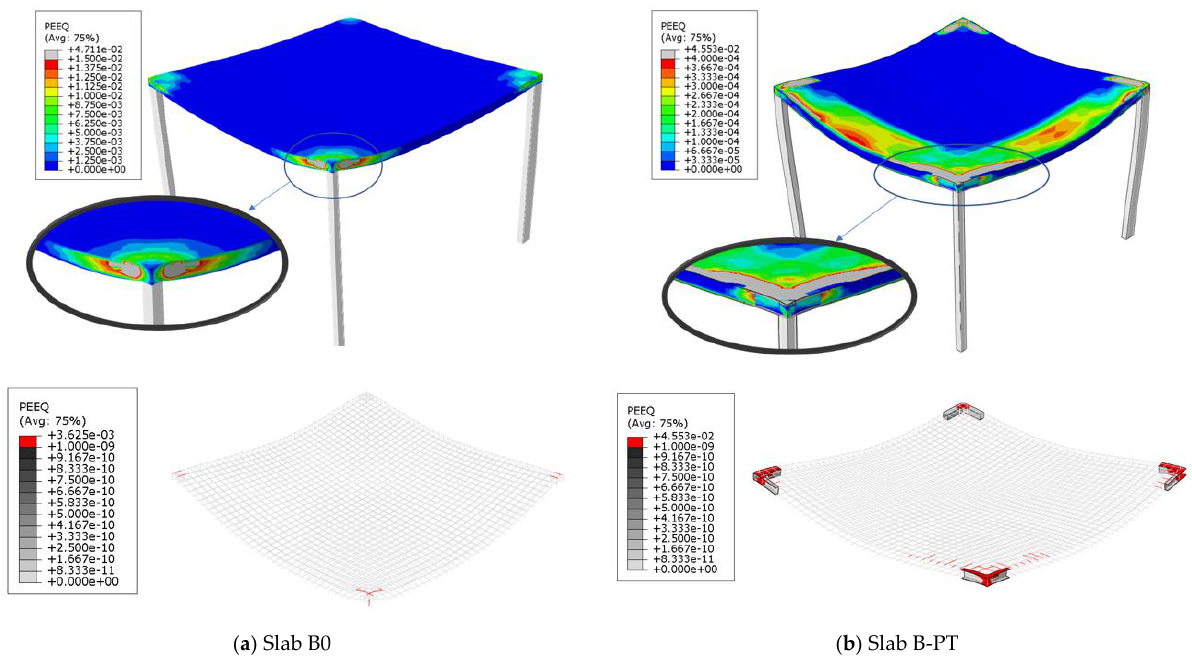
Figure 28. Numerical failure patterns for tested slabs.